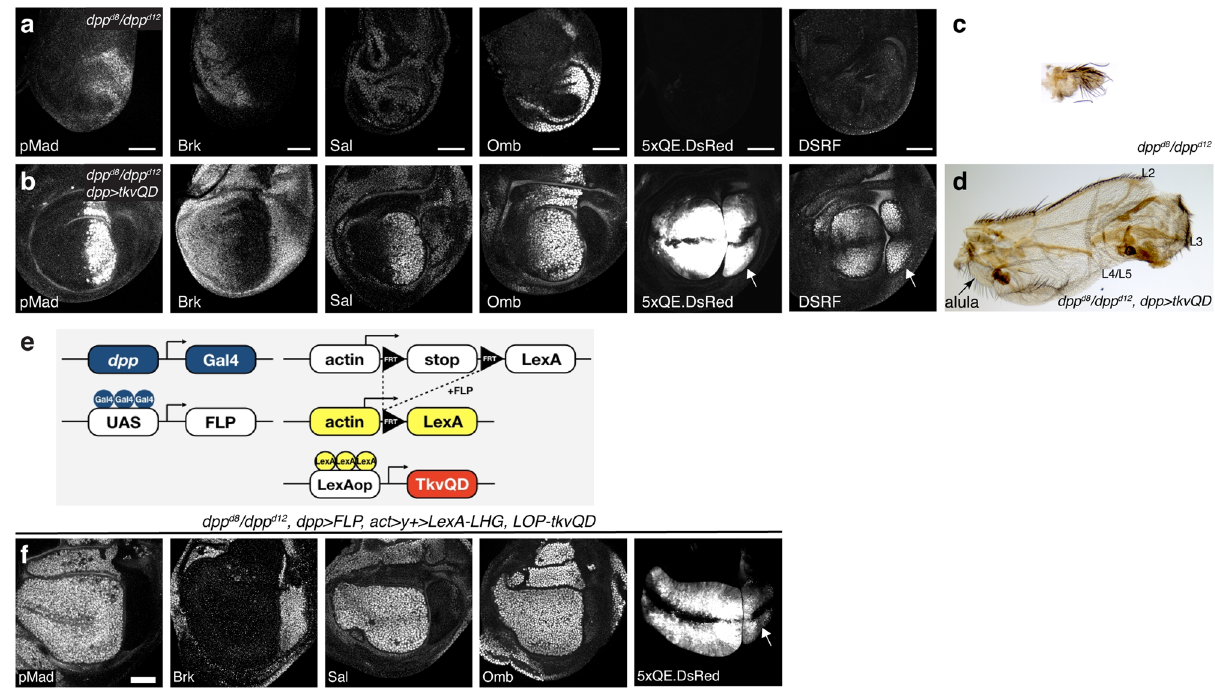
Fig. 6 Rescue of dpp mutant by cell-autonomous Dpp signaling. a , b α -pMad, α -Brk, α -Sal, α -Omb, 5xQE.DsRed, and DSRF staining of a dpp d8 /dpp d12 wing disc and b dpp d8 /dpp d12 , dpp > tkvQD wing disc. Arrows indicate rescued posterior wing pouch identi fi ed by 5xQE.DsRed and DSRF staining. c Adult wing of dpp d8 /dpp d12 . d Adult wing of dpp d8 /dpp d12 , dpp > tkvQD . e A schematic view of converting dpp-Gal4 into a LexA driver, which is permanently expressed in lineage of dpp-Gal4 expressing cells. In this experimental setup, the lineage of dpp-Gal4 (including lineage of non-speci fi c dpp-Gal4 expression) will permanently activate TkvQD and thus pMad signaling. f α -pMad, α -Brk, α -Sal, α -Omb staining, and 5xQE.DsRed signal of dpp d8 /dpp d12 , dpp > FLP, act > y + >LexA-LHG, LOP-tkvQD wing disc. Arrow indicates rescued posterior wing pouch identi fi ed by 5xQE.DsRed staining. Scale bar 50 μ